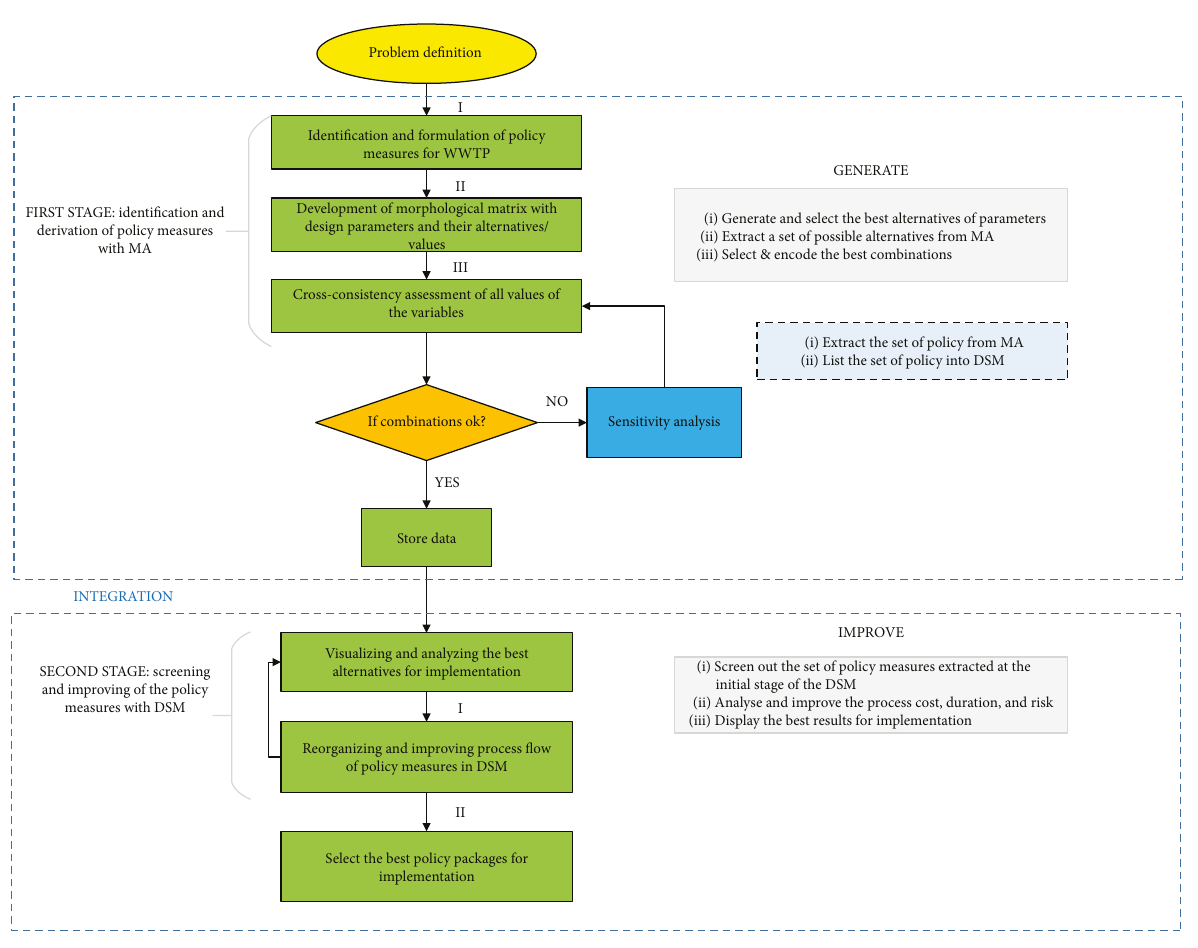
Figure 1: Process overview of the integrated general morphological analysis (GMA) and design structure matrix (DSM)